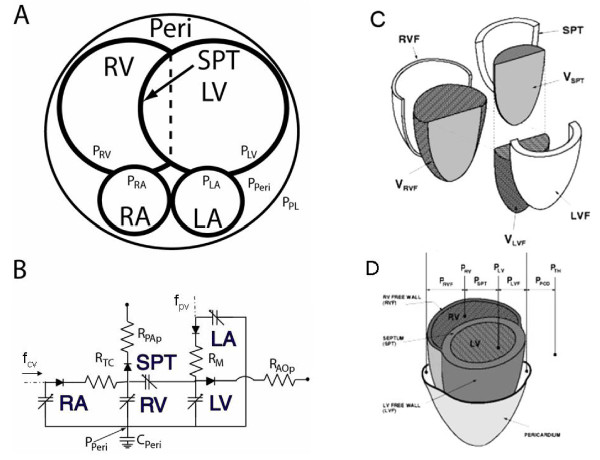
Coupled Pump Model of Heart. Panels 1A,C-D show coupled "pump model" of the human heart, with its chamber volumes and pressures. Panel 1B shows hydraulic equivalent circuit model, with diode-resistance pairs representing the pressure-dependent behavior of the tricuspid and mitral (inlet) valves RTC and RM; and the pulmonic and aortic (outlet) valves RPAp and RAOp. Time-varying compliances of the right atrium (RA), right ventricle (RV), left atrium (LA), left ventricle (LV), and septum (SPT) are included. The compliance of the pericardium (CPERI) is time-invariant.